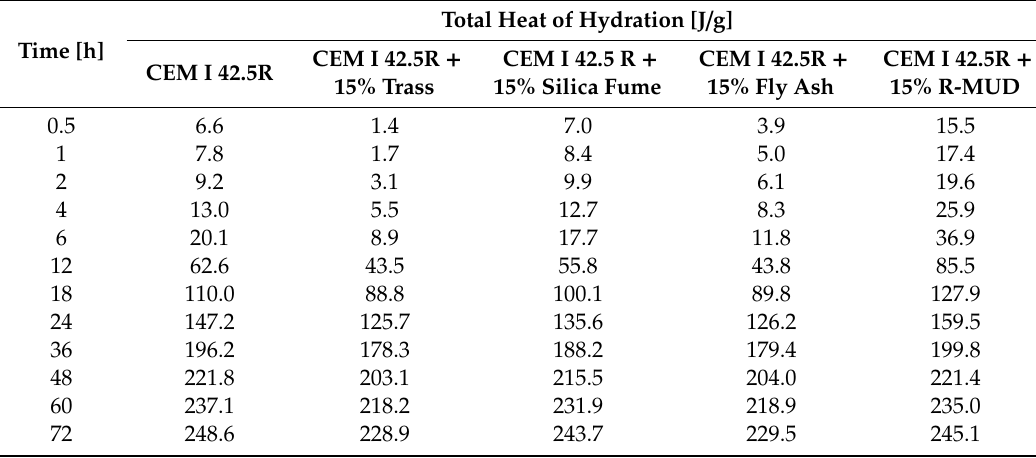
Table 4. Comparison of hydration heat released from CEM I 42.5R and cement with 15% addition of the tested